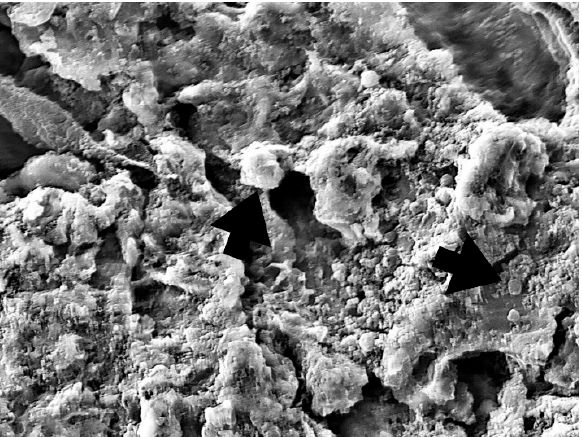
Figure 10. PDT1 group—bacterial and fungi reduction after 0.1% methylene blue and diode laser 660 nm treatment (5000×). Microorganism cells can still be observed (larger cell C. Albicans , smaller cell S. Aureus ) (arrow).